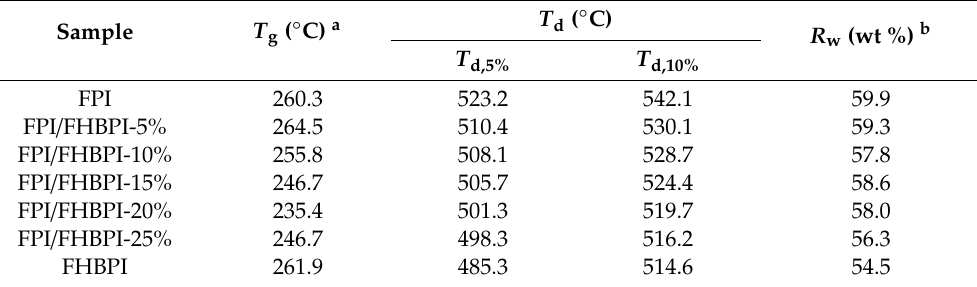
Table 1. Thermal properties of FPI, FPI / FHBPI composites and FHBPI.